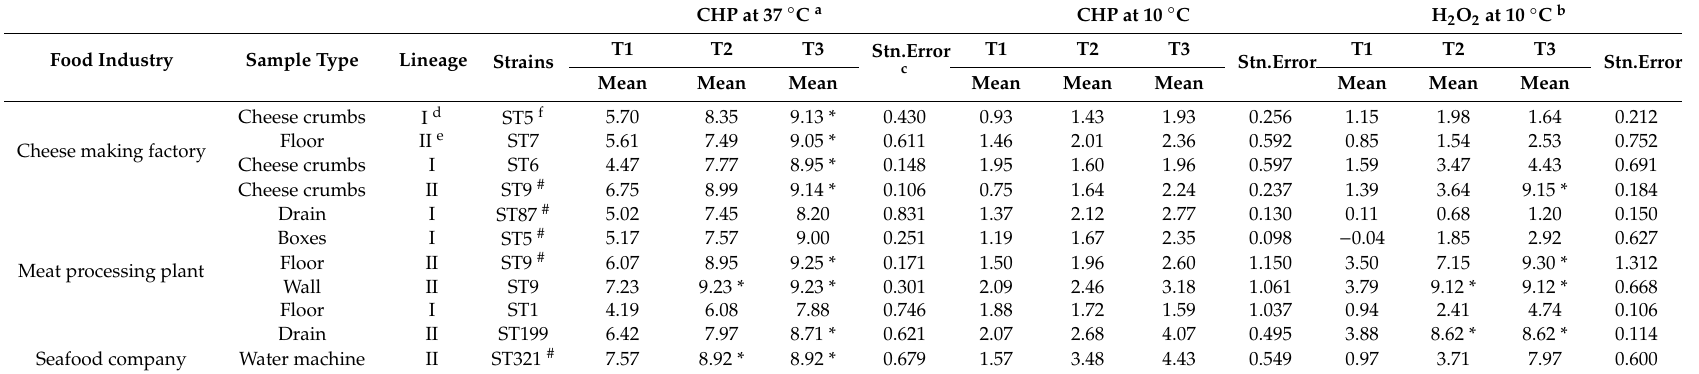
Table 1. L. monocytogenes log count reduction after exposure to oxidizing agents (CHP and H 2 O 2 ) at 37 ◦ C and 10 ◦